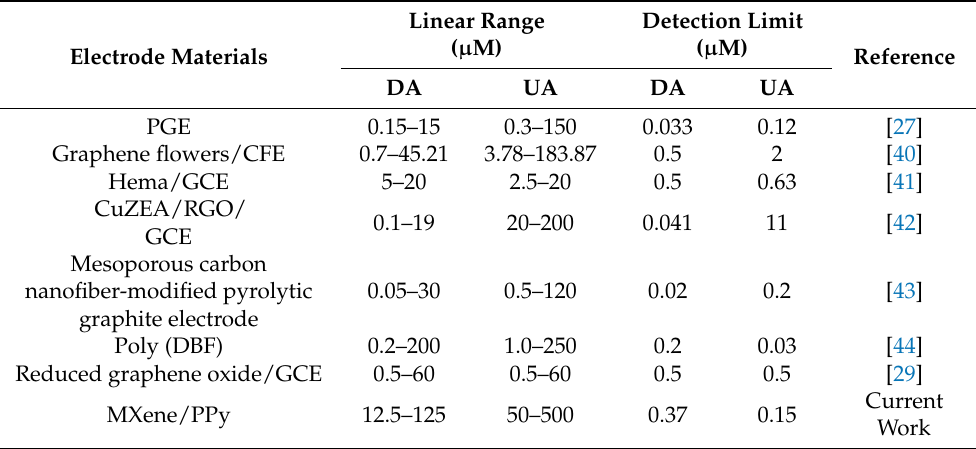
Table 1. Performance comparisons of various modified electrodes for the simultaneous determination of DA and